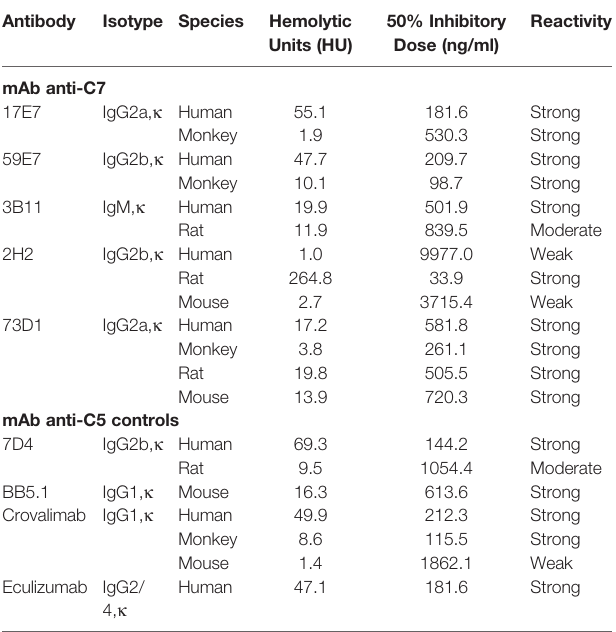
TABLE 1 | Summary of novel anti-C7 and control anti-C5 blocking mAb tested. Antibody Isotype